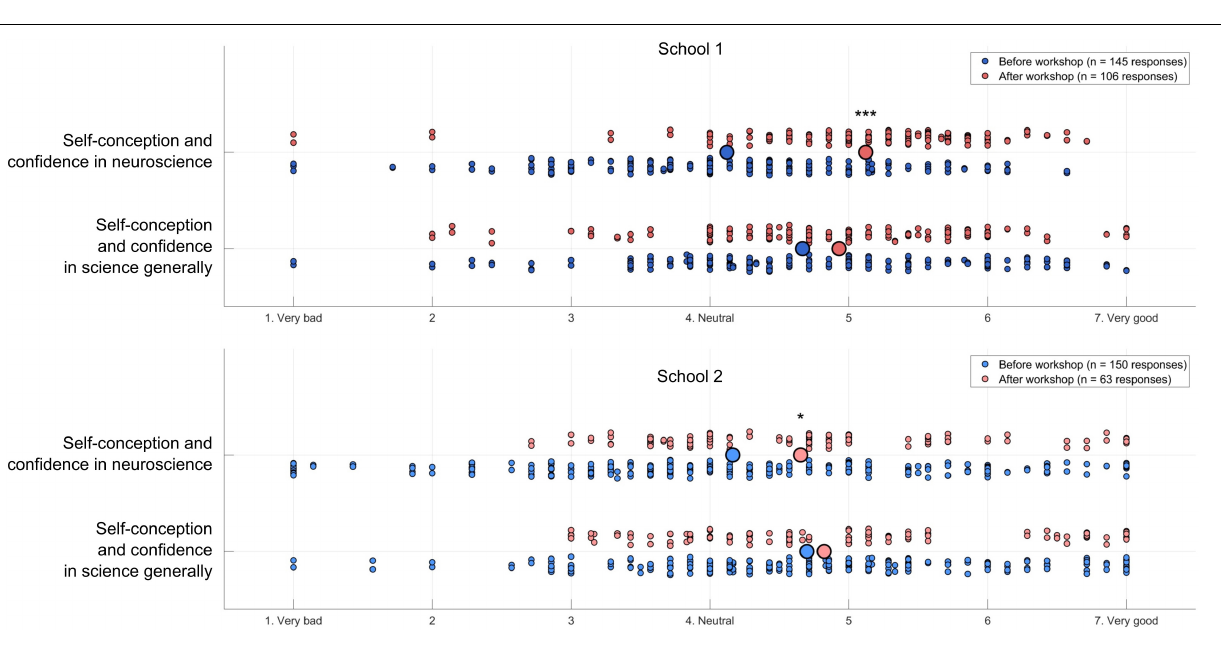
FIGURE 5 | Science attitudes survey results. Students’ results on a self-report science attitudes survey ( n = 295 pre-workshop responses, 169 post-workshop responses). Small dots represent individual students’ average level of agreement or disagreement with seven statements about their attitudes to neuroscience or science generally (see Supplementary Material for details). Large circles indicate average responses. Wilcoxon rank sum: * p < 0.05, *** p <